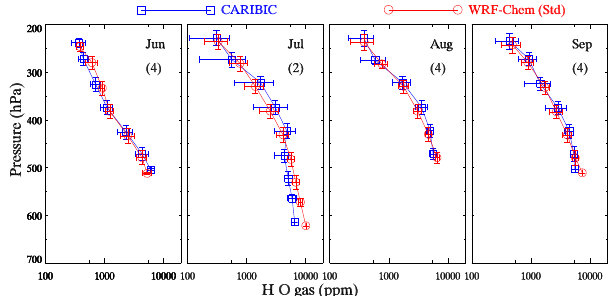
Figure 4. Comparison of monthly average H 2 O gas (ppm) from standard WRF-Chem simulations (Std) with the CARIBIC obser- vations during June, July, August and September 2008. Numbers in brackets denote the number of observational profiles in the respec- tive month. Model output has been spatially and temporally inter- polated along the CARIBIC flight tracks. Note the logarithmic scale on the x